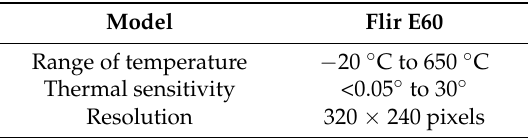
Table 3. Main features of the thermographic camera used.